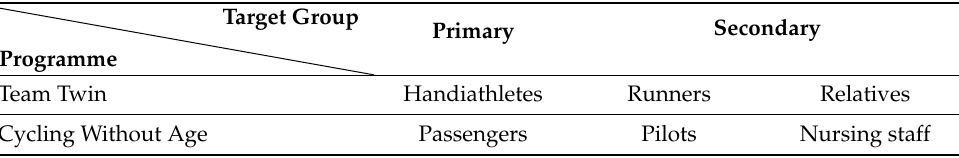
Figure 1. The target groups and their interrelated dependencies in the TT and CWA programmes, respectively. Table 1. Prioritised target groups of interest according to the two programmes the TT and CWA,